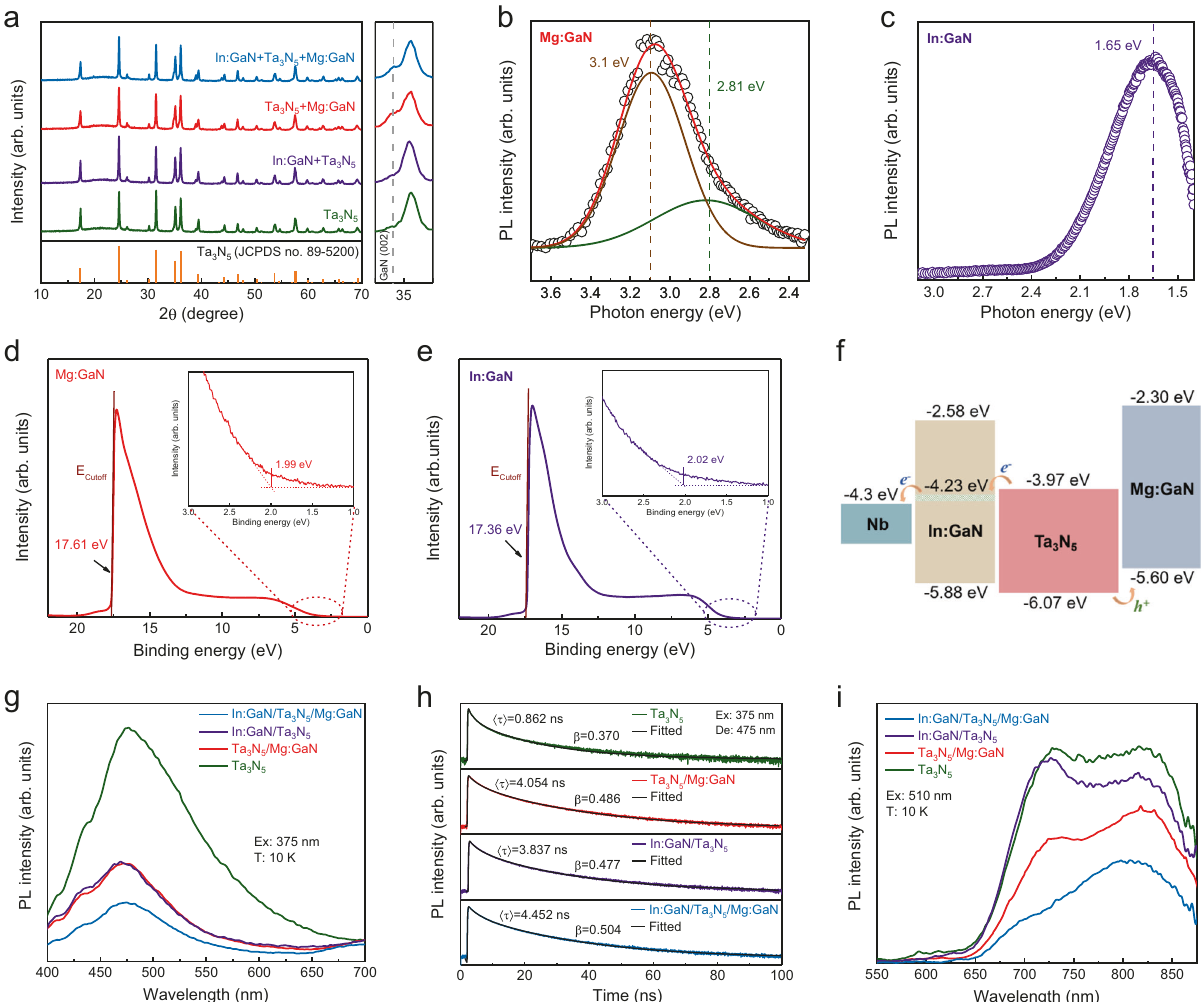
Fig. 3 Spectroscopic characterizations of GaN and Ta 3 N 5 -based thin fi lms. a XRD patterns of different Ta 3 N 5 -based fi lms deposited on quartz glass substrate. The narrow scan XRD patterns on the right side shows the (002) diffraction peaks of GaN. b PL spectra of Mg:GaN fi lm deposited on quartz glass substrate under 270 nm LED excitation. and c PL spectra of In:GaN fi lm deposited on quartz glass substrate under 375 nm laser excitation. d UPS spectrum of Mg:GaN deposited on Nb substrate. e UPS spectrum of In:GaN deposited on Nb substrate. f Schematic diagram of band structure for In:GaN/ Ta 3 N 5 /Mg:GaN fi lm determined from UPS and UV – vis absorption measurements. g PL spectra and h TRPL spectra of four Ta 3 N 5 -based fi lms on